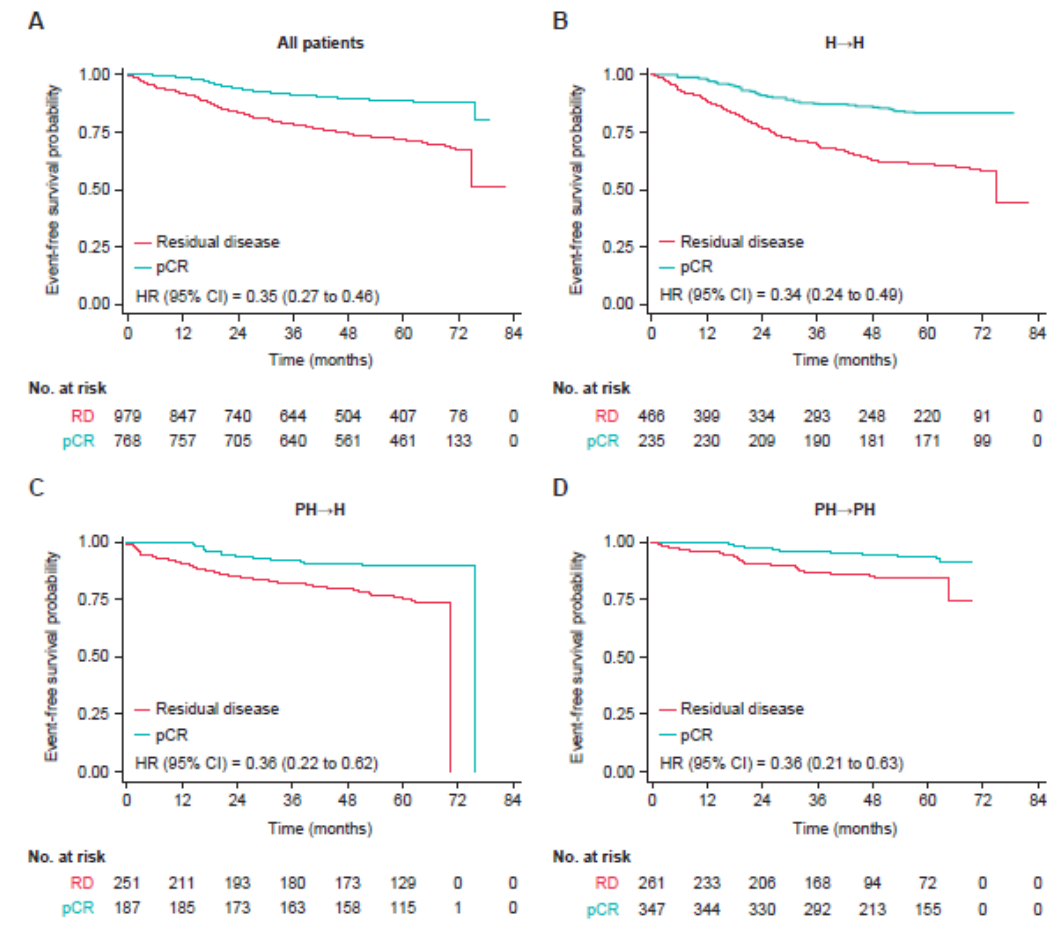
Figure 2. Event-free survival in patients with pCR after neoadjuvant systemic therapy ( A ) and in patients treated with trastuzumab in the neoadjuvant setting followed by trastuzumab in the adjuvant setting (H → H; ( B )), in patients treated with pertuzumab plus trastuzumab in the neoadjuvant setting followed by trastuzumab in the adjuvant setting (PH → H; ( C )), and in patients treated with pertuzumab plus trastuzumab in the neoadjuvant setting followed by pertuzumab plus trastuzumab in the adjuvant setting (PH → PH; ( D )). The inverse probability of treatment weighting method was used to account for imbalances in the baseline factors of hormone receptor status, clinical stage, and age group.